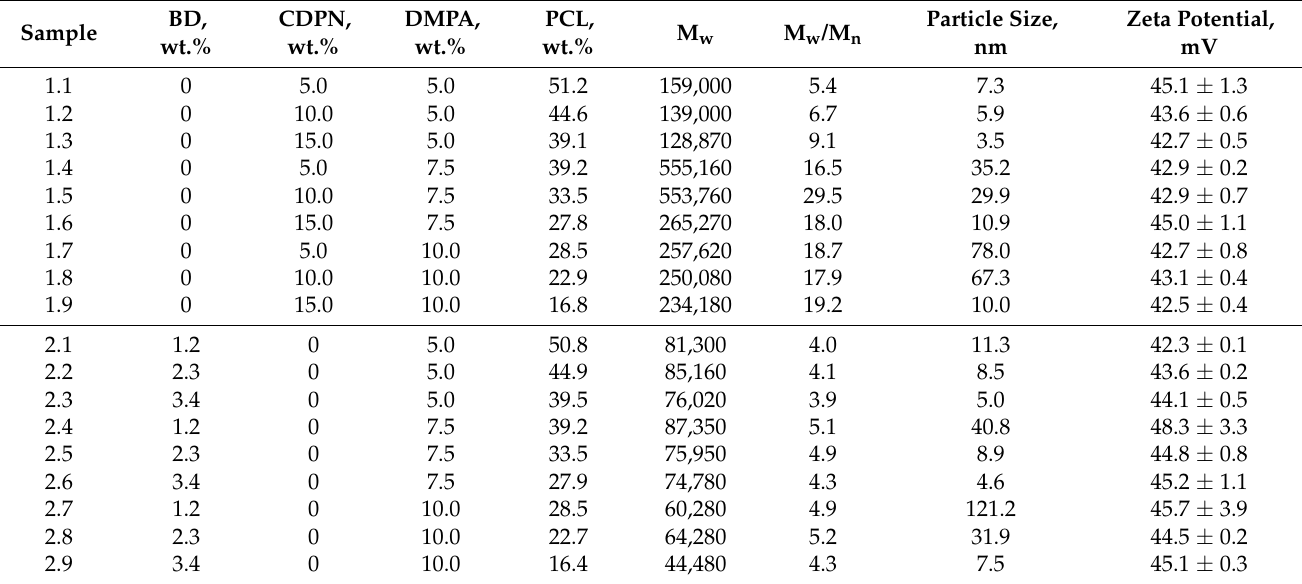
Table 4. Molecular weight, hydrodynamic characteristics, and zeta potential of WPU